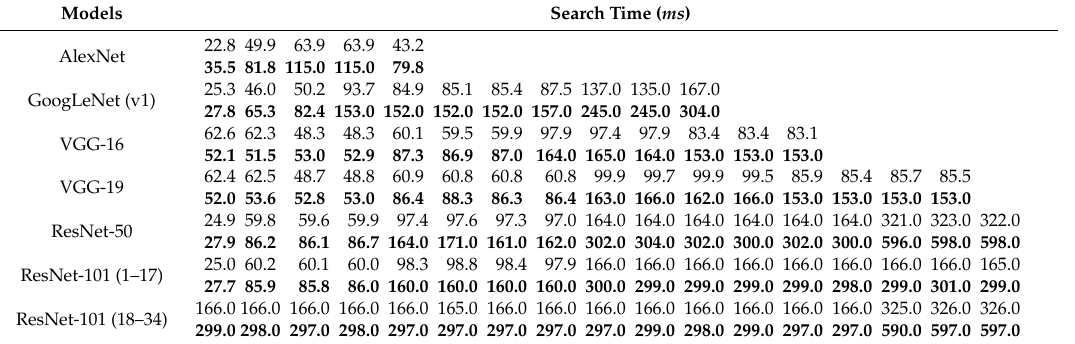
Table 5. Cache search time according to layer location measured by ODROID and LattePanda. Bold indicates